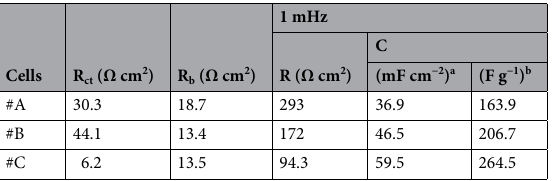
Table 2. Electrical parameters of supercapacitor cells from EIS analysis.